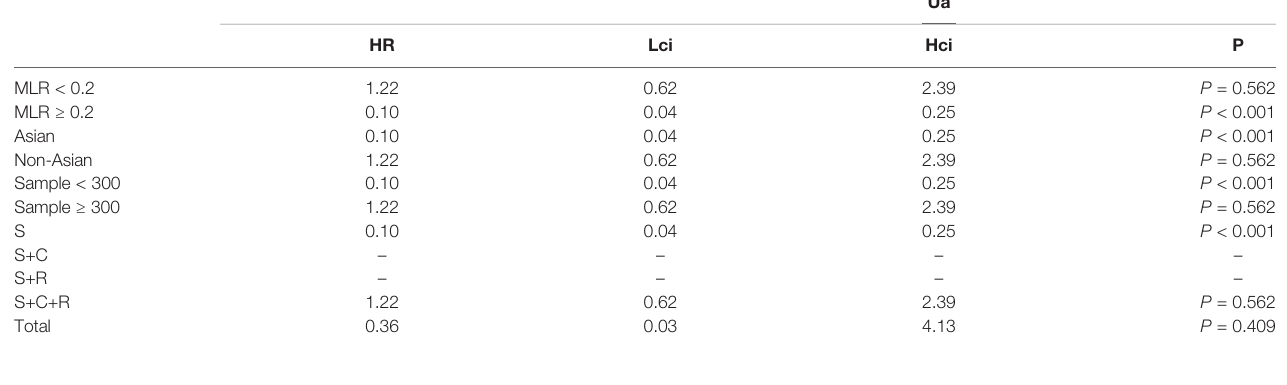
TABLE 8 | The results of the subgroup analysis for monocyte – lymphocyte ratio (MLR) and disease-free survival are summarized below. HR Lci Hci MLR < 0.2